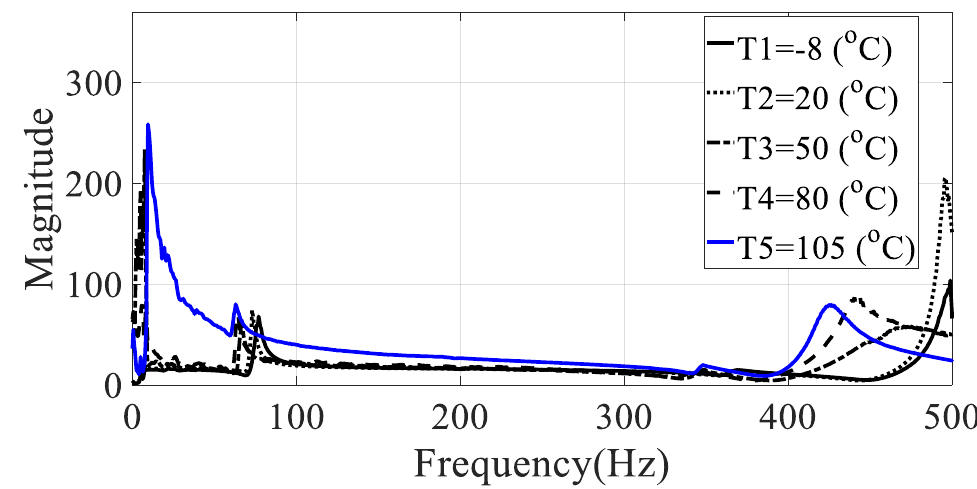
Figure 9. Representative frequency response function of specimen V ( φ = 90 degrees ).